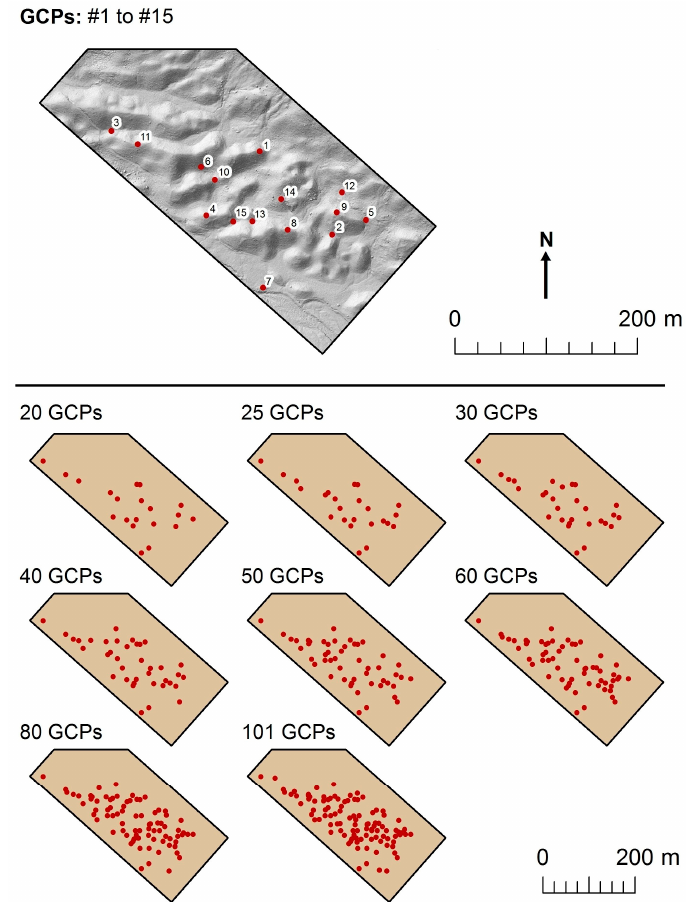
Figure 3. Ground control point (GCP) locations used to produce the 16 digital surface models (DSMs) reported in Table 1. The top panel relates to the models that use fewer than 15 GCPs. For example, for a model using 3 GCPs, the GCPs numbered 1, 2 and 3 were applied to the model. For a model using 7 GCPs, the GCPs numbered 1, 2, 3, 4, 5, 6, and 7 were applied to the model.